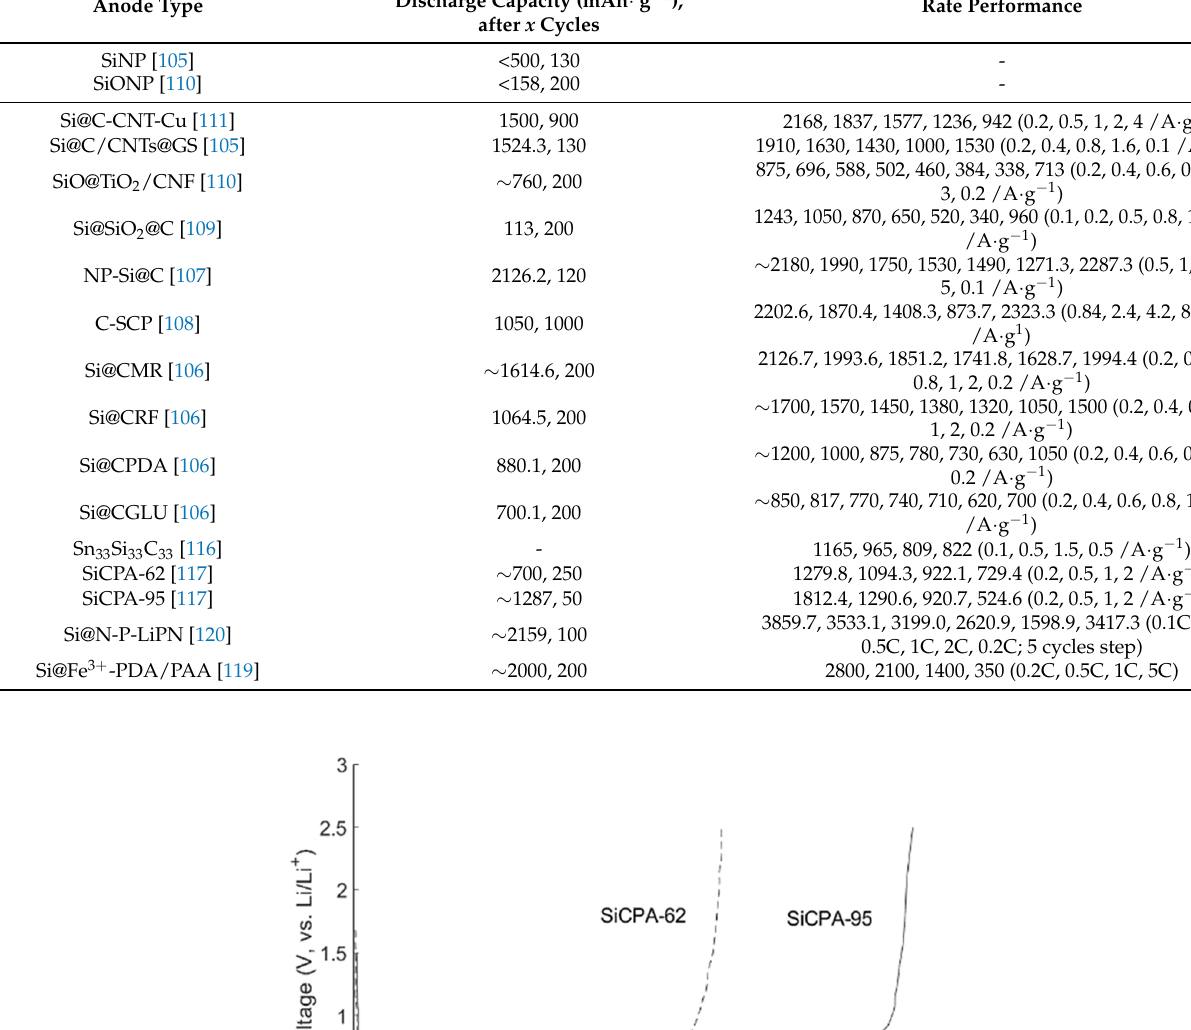
Table 6. Composite Si anodes proposed in recent years: discharge capacity after x cycles and rate performance. Anode Type